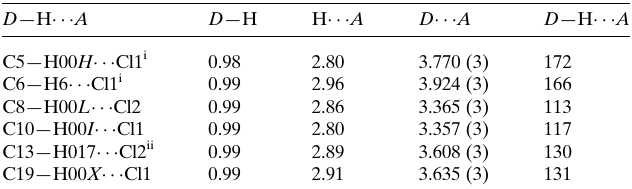
Table 2 Hydrogen-bond geometry (A˚ , (cid:4) ).